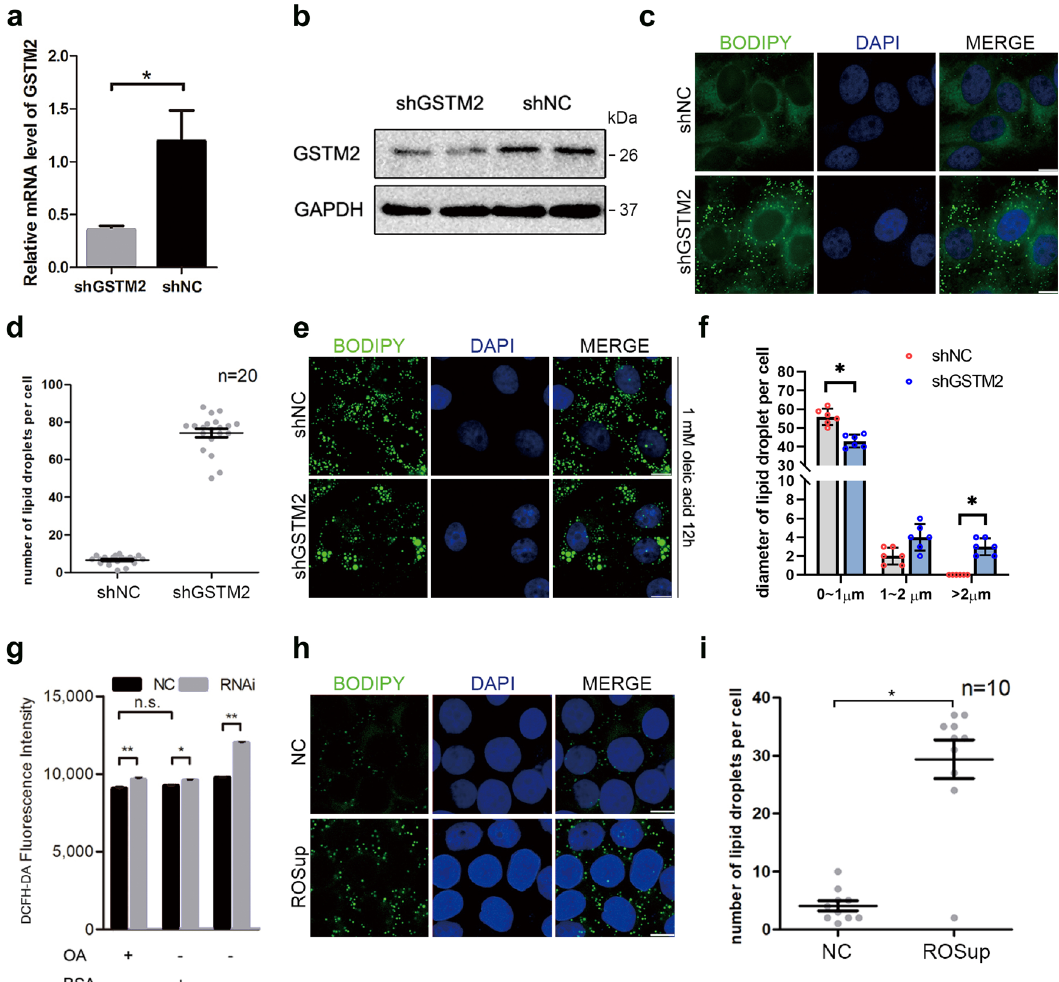
Fig. 3 GSTM2 modulated cellular lipid droplets accumulation via regulating cellular ROS level. a , b Expression level of GSTM2 was detected in shGSTM2-HepG2 cells and corresponding control cells. c More LDs were observed in shGSTM2-HepG2 cells. d Statistics of LD number in shGSTM2- HepG2 cells and shNC-HepG2 cells. e More larger LDs were found in shGSTM2-HepG2 cells treated with 1 mM oleic acid medium for 12 h compared to control cells. f Statistics of LD diameter in shGSTM2-HepG2 cells and shNC-HepG2 cells treated with 1 mM oleic acid medium for 12 h compared to control cells. g Cellular ROS level was detected in shGSTM2-HepG2 and shNC-HepG2 cells in the presence or absence of oleic acid medium; * p < 0.05, ** p < 0.01. h More LDs were observed in cells treated with ROSup compared to control cells. i Statistics of LD number in cells treated with ROSup and control cells. Bar, 10 μ